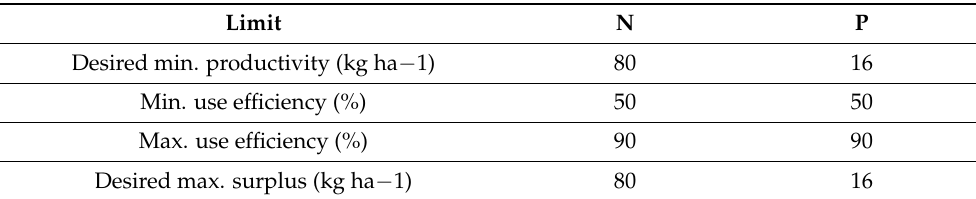
Table A5. Nitrogen (N) and phosphorus (P) limits that create the sustainability area for the N use efficiency (NUE) and P use efficiency (PUE) graphical evaluation.